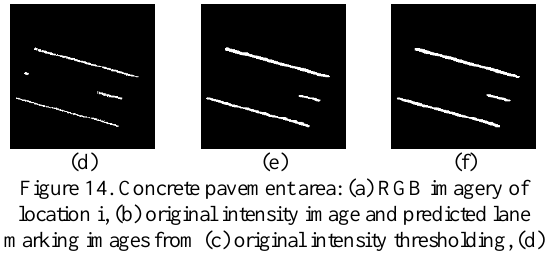
Figure 14. Concrete pavement area: (a) RGB imagery of location i, (b) original intensity image and predicted lane marking images from (c) original intensity thresholding, (d) normalized intensity thresholding, (e) U-net model 1, and (f) U- net model